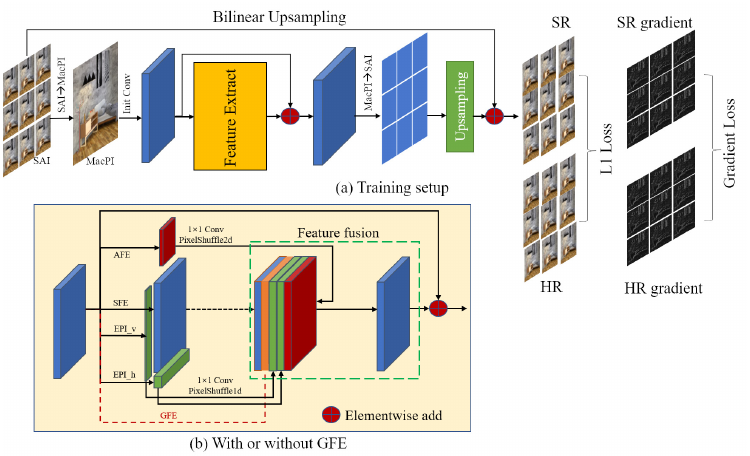
Figure 4. Experiments setup. ( a ) Training model by Adam optimizer [35] and two losses. ( b ) With/without Global feature extract for